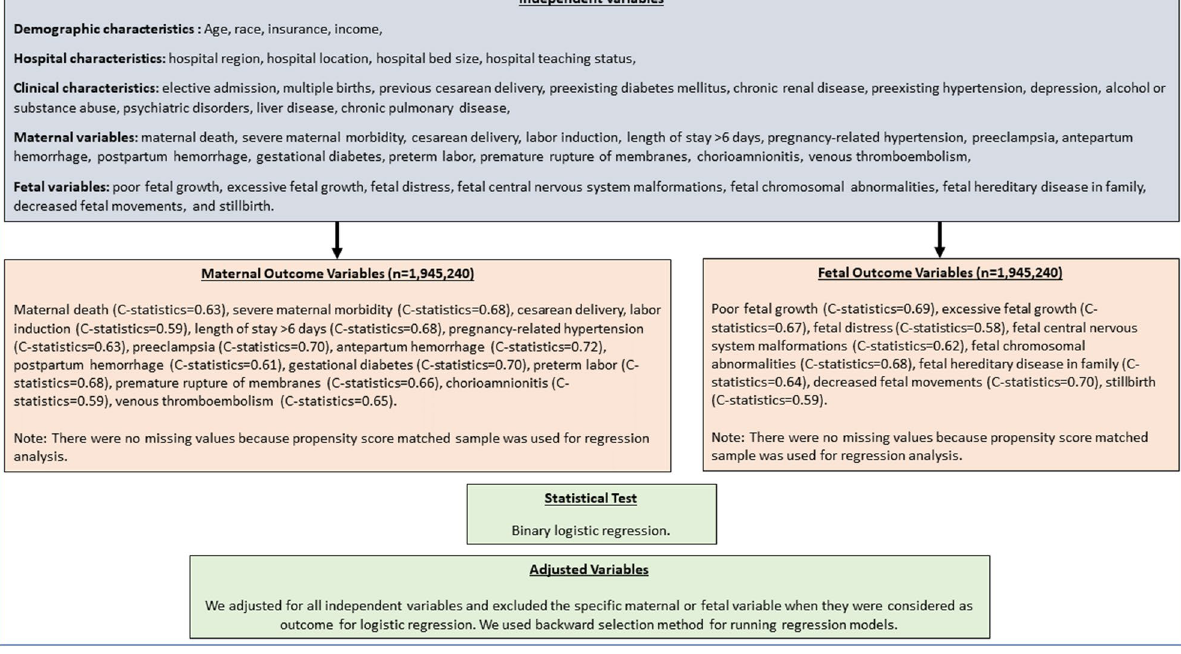
Figure 2. List of independent and dependent variables, c-statistics, and how the variables were controlled for in the regression